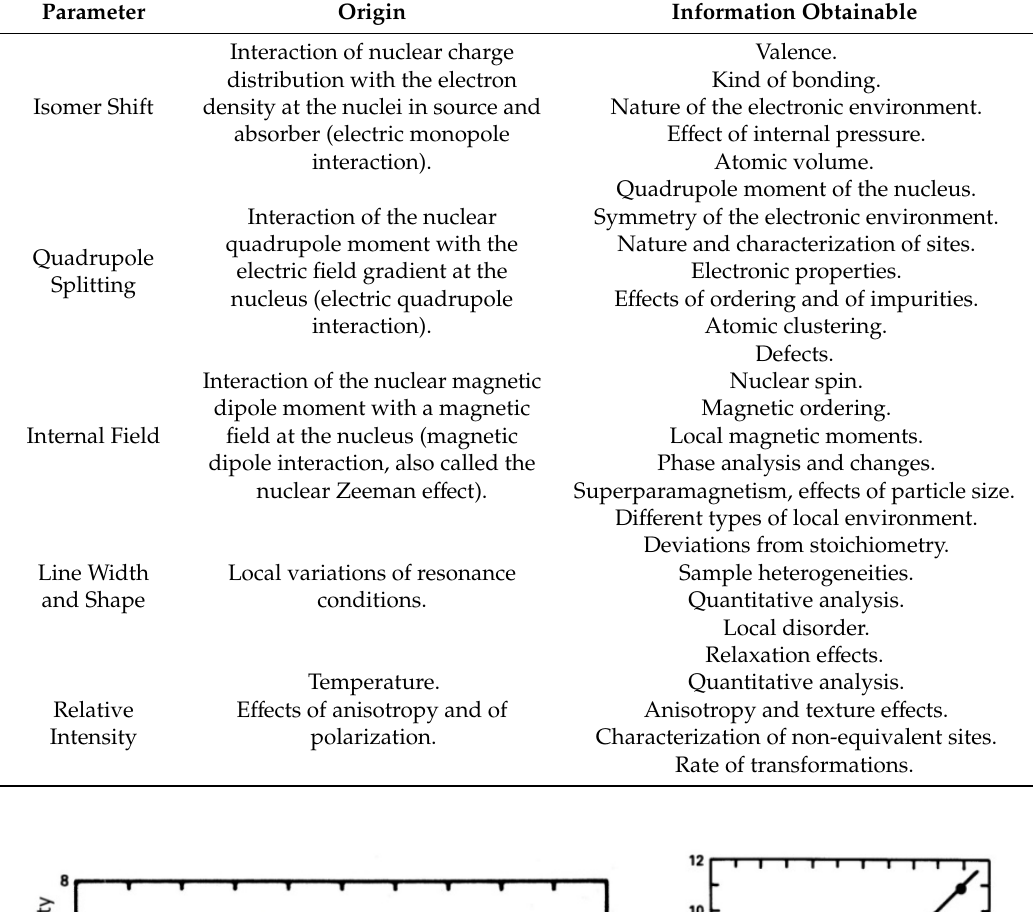
Table 3. Scheme of applicability of Mössbauer spectroscopy (MS) to materials science.